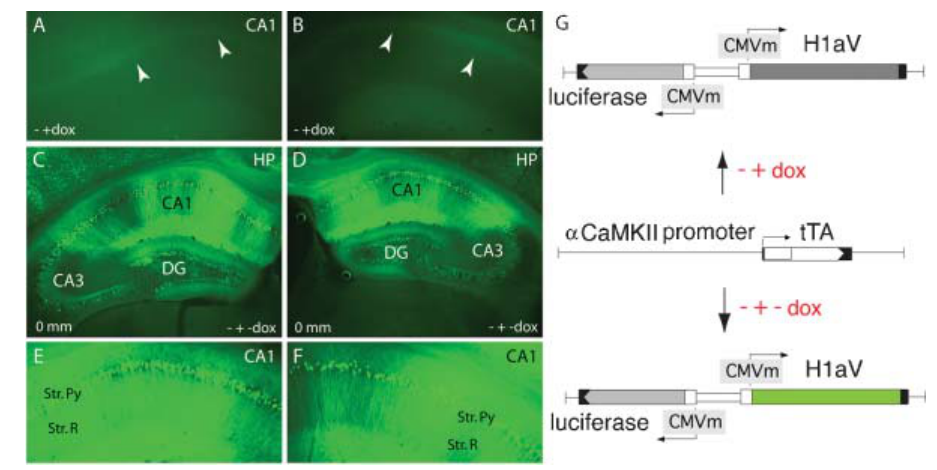
Figure 5. Tetracycline-regulated expression of TgH1aV.Fb . ( A , B ) Representative coronal section through the CA1 region of the hippocampus ( ∼ 0mm from bregma) of a 19 week-old mouse after three weeks on dox (0.1g/l of drinking water), demonstrating absence of GFP-enhanced H1aV fluorescence. White arrowheads point at the position of the CA1 pyramidal cell layer. − +dox indicate the chronology of dox application. ( C , D ) Comparable sections as in A and B , showing robust re-induction of GFP-enhanced H1aV fluorescence 3 weeks after dox withdrawal. CA1, CA2, and CA3 mark the three morphologically distinct subregions of the hippocampal pyramidal layer. Zero millimeter indicates the position from the bregma. − + − dox explains the chronology of dox application. ( E , F ) Magnification of the CA1 subregion shown in C , and D . Strong GFP-enhanced H1aV fluorescence was detected in both, the pyramidal cell bodies of the stratum pyramidale and in the dendrites of the stratum radiatum. ( G ) Schematic representation of the transgenes driving H1aV expression in the mouse forebrain. The luc and H1aV genes are expressed from a bidirectional transcription unit (upper and lower chart) activated by binding of tTa, expressed under the control of the mouse (cid:2) CaMKII promoter (middle chart), to the heptamerized tet operator sequences flanked by CMV minimal promoters. Dox application can shut off transgene expression ( A , B , G upper chart), which can be re-induced by withdrawal of dox ( C – G , lower chart).